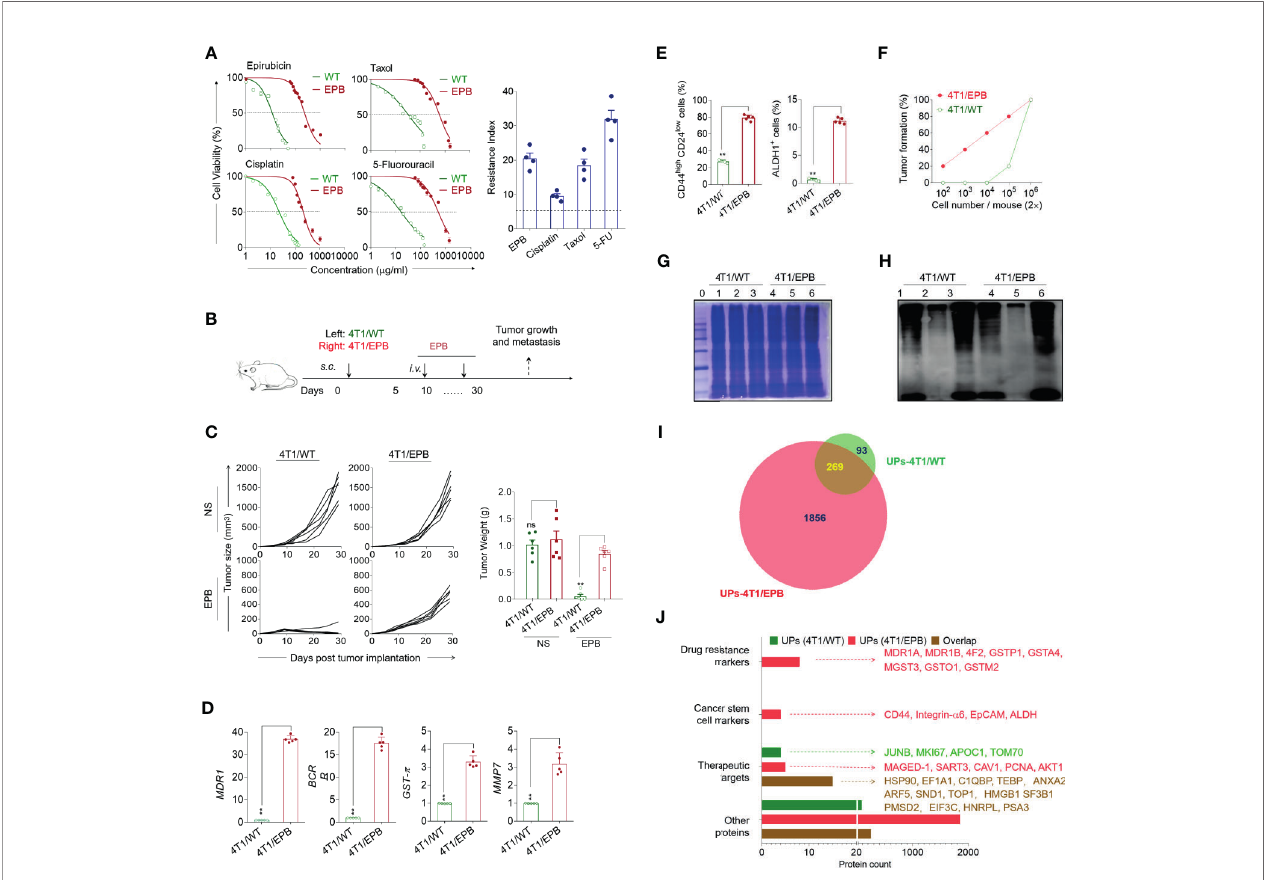
FIGURE 1 | Multi-drug-resistant and breast cancer stem cell-like features of the newly established 4T1/epirubicin (EPB) cells and expanded ubiquitinated protein (UP) spectrum with related markers and therapeutic target-associated proteins. (A) The cell viability of 4T1/WT cells and 4T1/EPB cells was assessed at varying concentrations of EPB, cisplatin, Taxol, and 5- fl uorouracil, respectively, to calculate IC50 values and resistance index. (B) Scheme of the in vivo drug sensitivity experimental protocol. (C) Tumor growth and tumor weight of tumor-bearing mice ( n = 6 per group) in (B) . (D) qRT-PCR analysis was applied to the expression of MDR1, BCRP, GST- p , and MMP7 in 4T1/WT and 4T1/EPB cells. (E) The expression of CD44 high CD24 low population and ALDH1 activity on 4T1/WT cells and 4T1/ EPB cells was determined by fl ow cytometry. (F) The tumorigenicity of 4T1/WT cells and 4T1/EPB cells in BALB/c mice was detected ( n = 5 per group). (G) The equal protein loading of the protein marker (lane 0), whole cell lysate (lane 1 and lane 4), unbound lysate (lane 2 and lane 5), and a -Al 2 O 3 -Vx3-UPs (lane 3 and lane 6) from 4T1/WT cells and 4T1/EPB cells was veri fi ed by SDS-PAGE electrophoresis and Coomassie blue stain. (H) The protein levels of the ubiquitin in (G) were determined by western blot. (I) Venn diagram showing the overlap between the 362 proteins identi fi ed in UPs from 4T1/WT cells by LC – MS/MS analysis (green) and the 2,125 proteins identi fi ed in UPs from 4T1/EPB cells (red). (J) Bar chart showing the number of proteins classi fi ed according to the following categories: drug resistance markers, cancer stem cell markers and therapeutic targets, and other proteins in (I) . P -values were determined by Mann – Whitney U -test. The results are representative of three independent experiments, and data were expressed as means ± SEM (** p < 0.01; ns, not signi fi